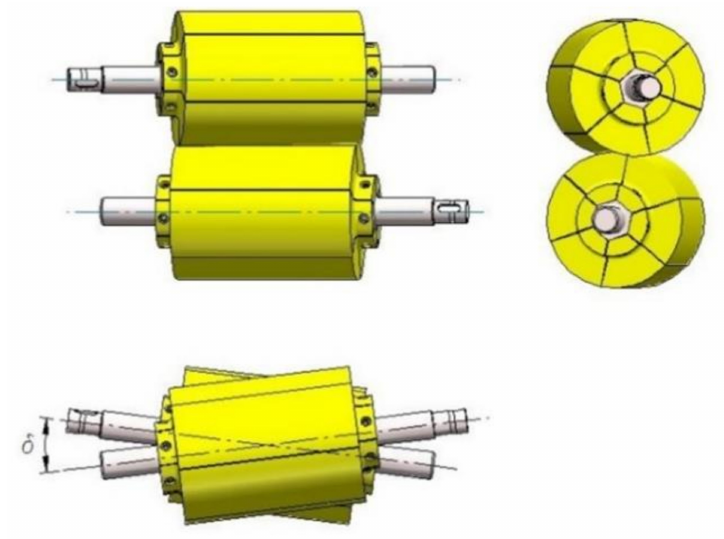
Figure 1. Diagram of the skew rolling